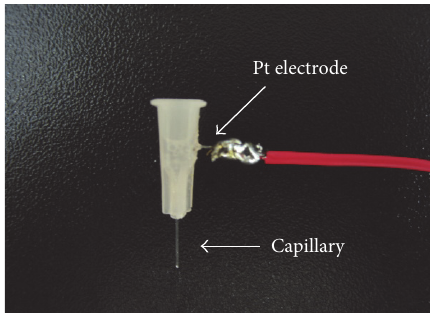
Figure 1: A photographic image of a homemade capillary needle designed for AICEI method. The tip was grinded into a slant face. Pt electrode was inserted and firmly fixed into the cone of a capillary